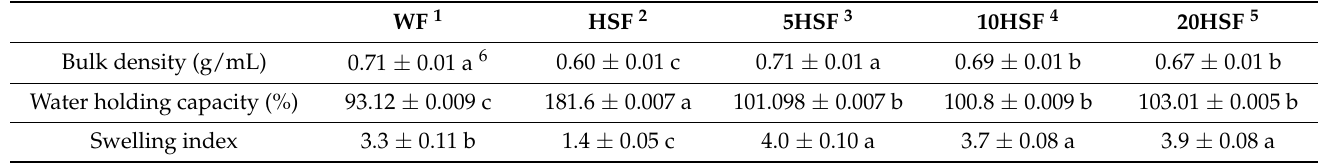
Table 2. Functional properties of wheat flour, hemp seed flour, and composite